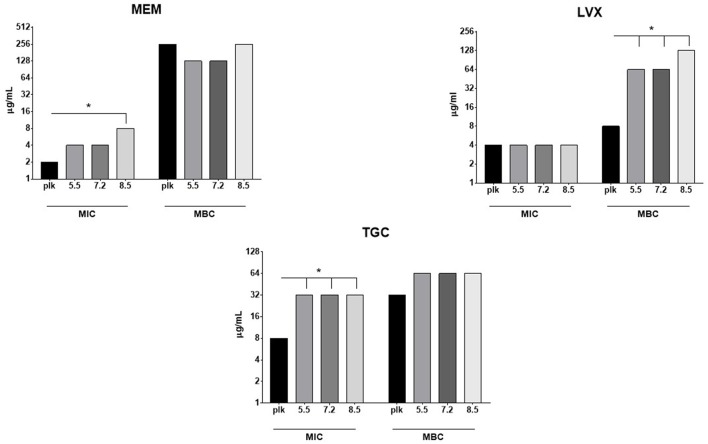
Antibiotic susceptibility of planktonic and biofilm Myroides odoratimimus cells. MIC and MBC values of several antibiotics were measured against planktonic (plk) and biofilm Myroides odoratimimus cells. Sessile (biofilm) cells were obtained following disruption of a 7 day-old biofilm grown in collagen gel matrix, in the presence of glucose 12.5 mM and at different pH values (5.5, 7.2, and 8.5) (bars with different scale of grays). *Differences between MIC or MBC values were statistically significant if ≥2 log2. MEM, meropenem; LVX, levofloxacin; TGC, tigecycline.